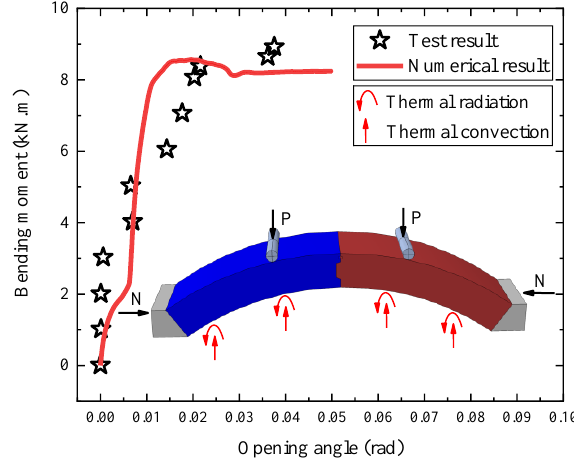
Figure 7. Comparison between the M- θ curves of specimen RCJ3 and the analytical model. Table 4. Comparison between numerical simulation and experimental results of the tunnel segmen- tal joint.